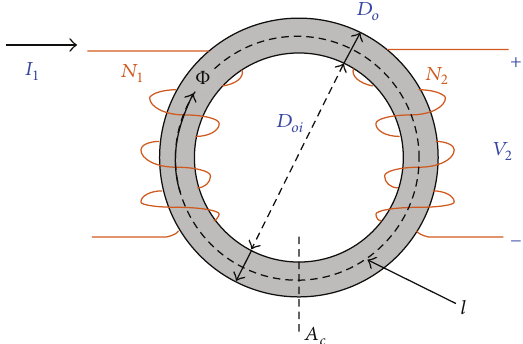
Figure 8: Schematic diagram of the toroidal electromagnetic coil.